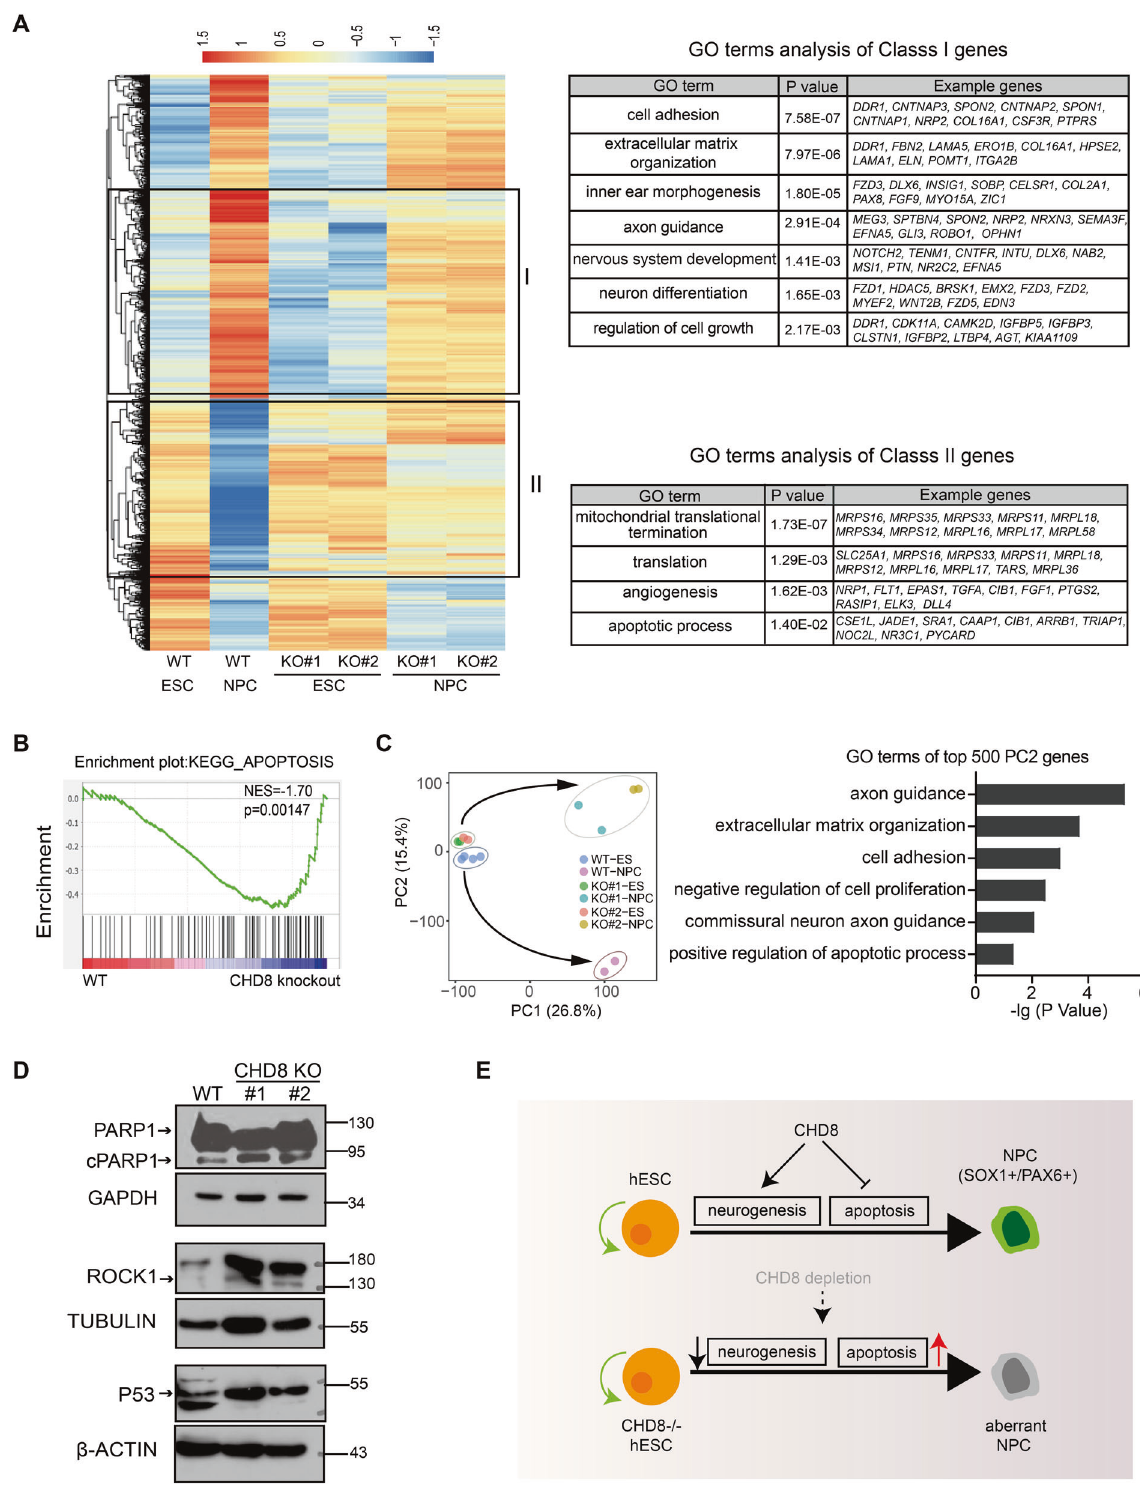
Fig. 7 CHD8-KO blocks the activation of neural genes and results in derepression of apoptosis-related genes during neuroectoderm differentiation. A Heatmap showing CHD8-KO affected genes during neuroectoderm differentiation. Go terms of these genes (i.e., class I and class II genes) were also shown. B The GSEA showing the expression pattern of apoptosis-related genes in WT and CHD8-KO NPCs. C The PCA correlation map of WT and CHD8-KO in ESCs and NPCs and the GO terms of top PC2 genes. D Western blot analysis showing the PARP1, ROCK1, and P53 protein expression in WT and CHD8-KO NPCs. cPARP1 represents the cleaved PARP1. E The cartoon showing the different roles of CHD8 in ESCs and NPCs.